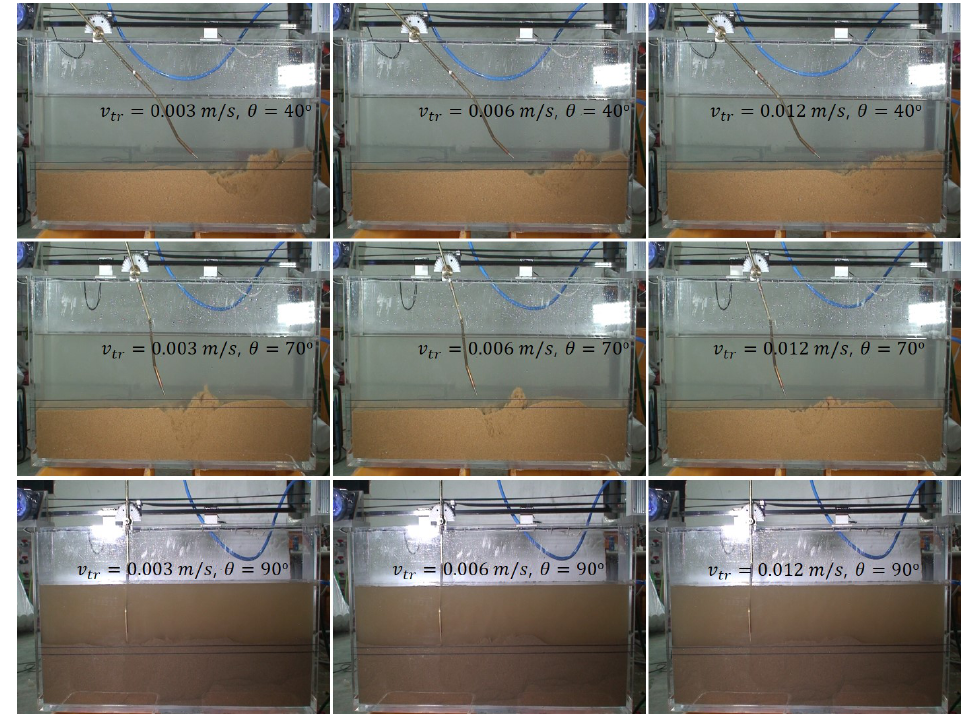
Figure 4. Some of the jetting angle experiment